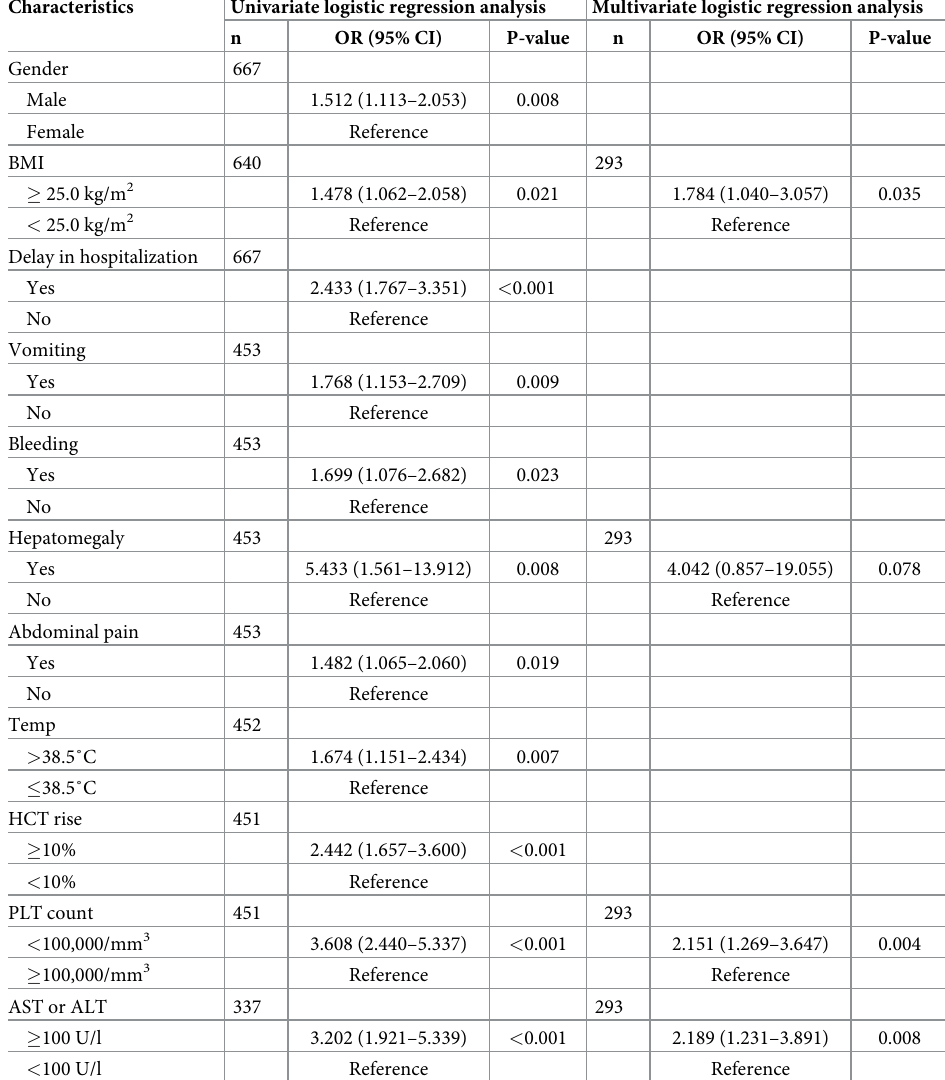
Table 6. Univariate and multivariate logistic regression to determine independent risk factors associated with plasma leakage among dengue patients.